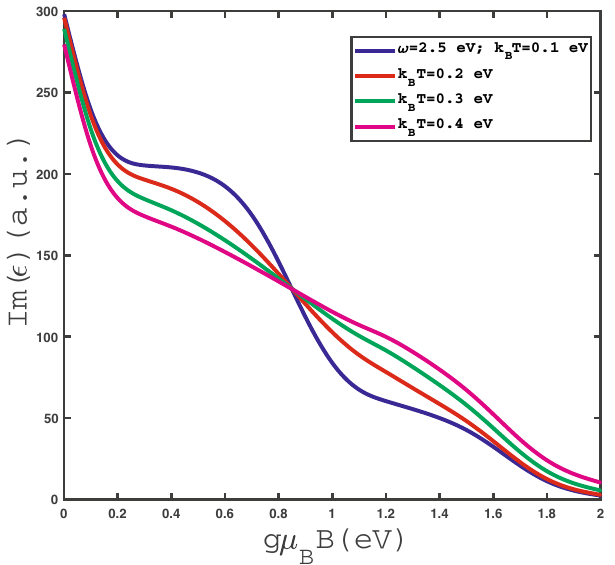
Figure 3. Optical absorption, Im (ǫ) , of undoped MoS 2 layer as a function of magnetic field g µ B B at fixed 2.5 eV for different values of temperature in the absence of strain. photon frequency ω =